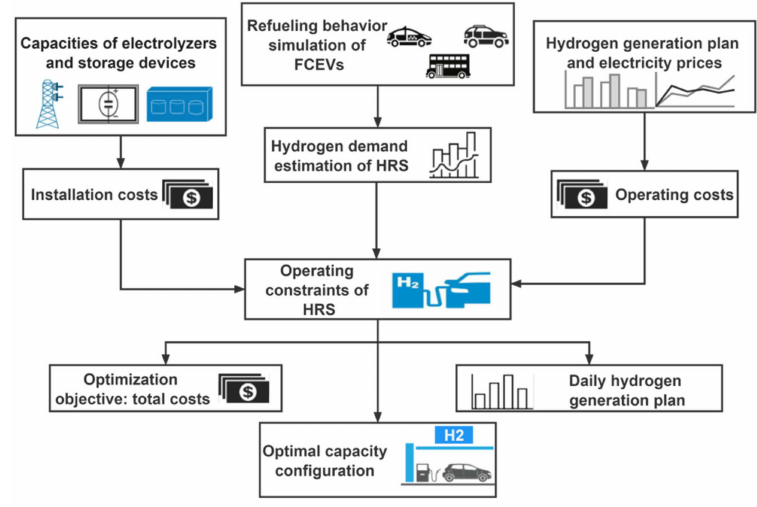
Figure 1. Structure of the proposed optimization